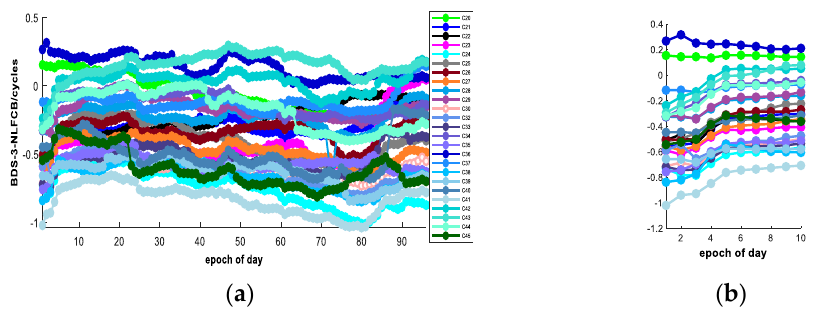
Figure 6. NL FCB of BDS-3 estimated by using the traditional method (reference satellite is C19) as